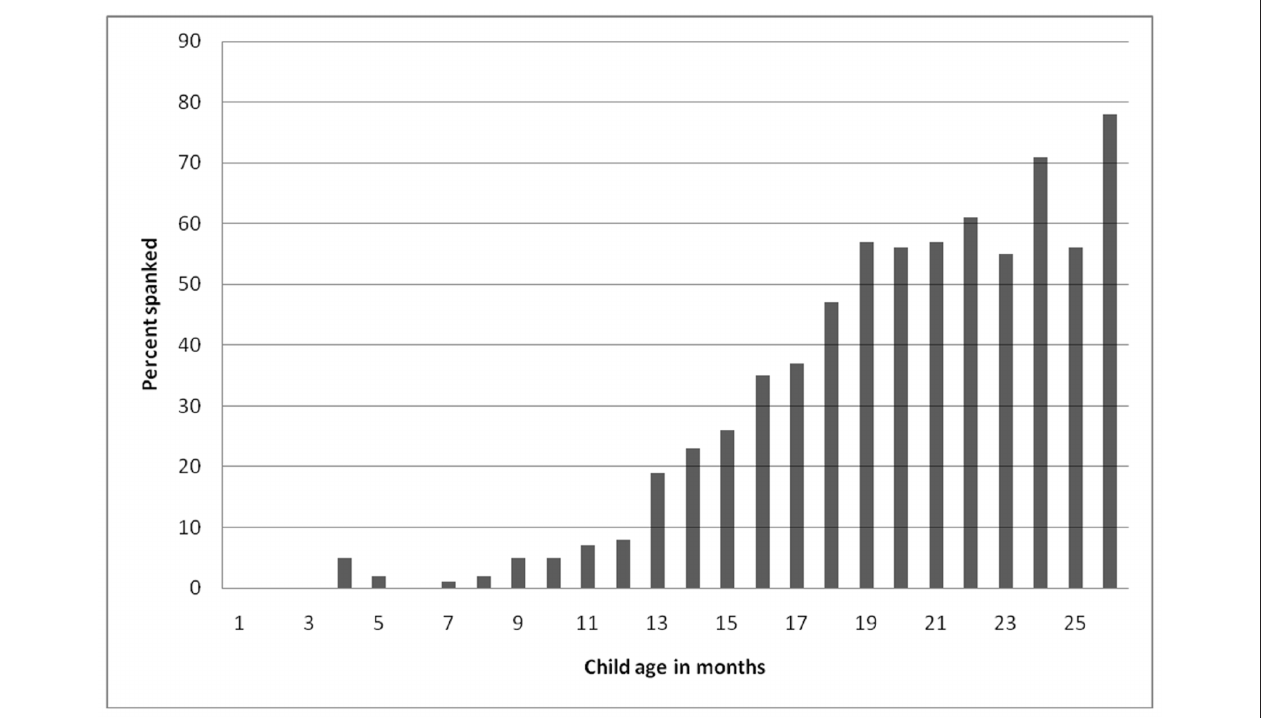
FigUre 2 | Percent mother reported spanking by child age in months (weighted